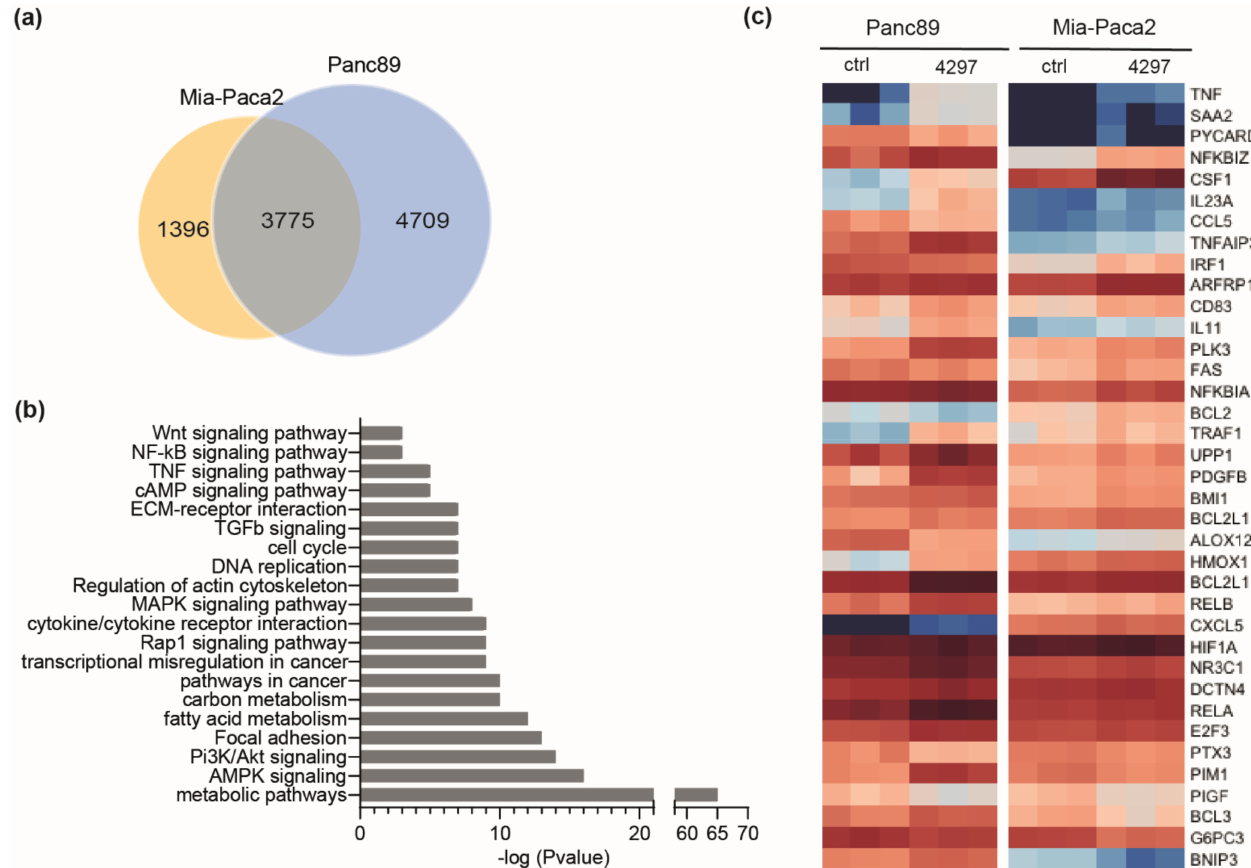
Figure 5. Prolonged limited inhibition of CDK7 leads to activation of NF- κ B target genes. ( a ) Venn diagram representing number of genes deregulated in Panc89 and Mia-Paca2 cells after treatment with 0.1 µ M LDC4297 for 4 days as determined by RNAseq analysis. ( b ) KEGG pathway analysis of genes deregulated in both Panc89 and Mia-Paca2 cells by treatment with 0.1 µ M LDC4297 for 3 days. ( c ) Heatmap of NF- κ B target genes, which are significantly regulated in Panc89 and Mia-Paca2 cells in RNAseq analysis, sorted according to regulation in Mia-Paca2. Upregulation: 76% in Panc89, 84% in Mia-Paca2. Downregulation: 24% in Panc89, 16% in